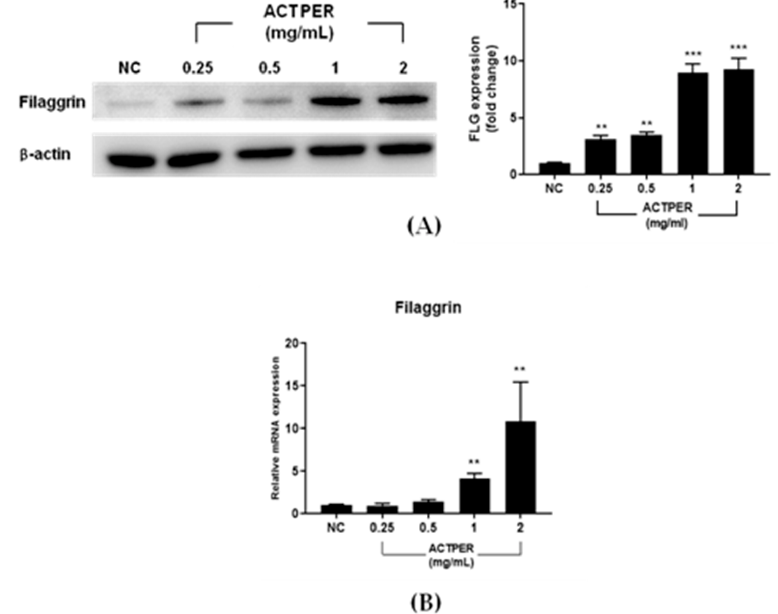
Figure 5. ACTPER promotes the expression of filaggrin in HaCaT cells. ( A ) Changes in the level of filaggrin protein; ( B ) Changes in the RNA level of filaggrin. Values represent the mean ± S.E.M. of three independent experiments. ** p < 0.01 compared with control group.